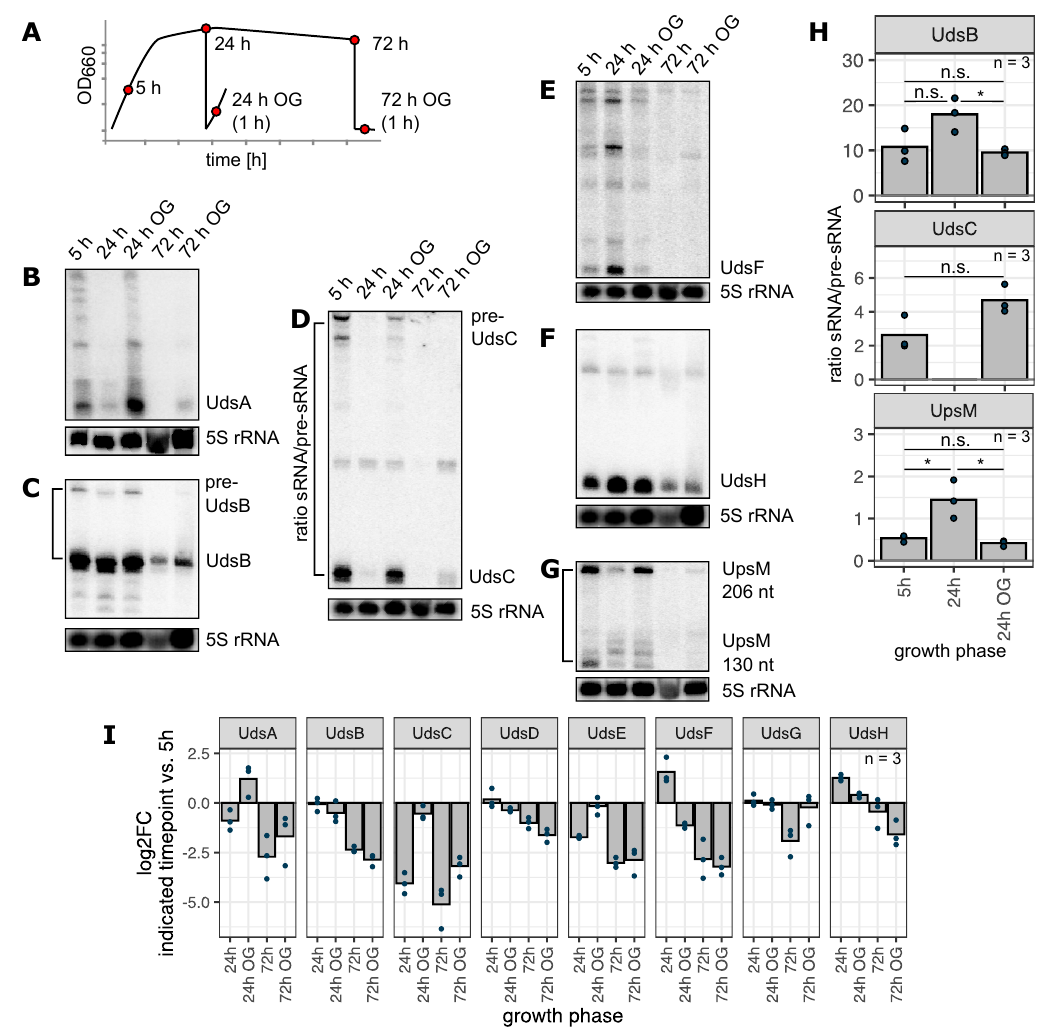
Figure 4. The UTR-derived sRNA levels strongly depend on the growth phase. ( A ) R. sphaeroides wild type cultures were incubated for 72h under microaerobic conditions. Cells were harvested at the depicted times (red dots). After 24 h and 72h, outgrowth cultures were inoculated. ( B – G ) Total RNA from the depicted samples was analyzed by northern blot using specific probes against UdsA to UdsH and UpsM. The sRNA levels vary throughout the different growth phases and can be increased or decreased when compared to the levels during the exponential phase. Loading control: 5S rRNA. Full blots with samples from biological triplicates are shown in Figure S5. Membranes were used with multiple probes: UdsA, UdsD and UdsE; UdsB, UdsG,UdsH and UpsM; UdsC and UdsF. ( H ) Signals of the sRNAs UdsB, UdsC and UpsM and their corresponding pre-sRNAs were quantified and the ratio was calculated (y-axis). Bars indicate the mean value, every dot represents one biological replicate, n = 3. Groups were compared with the two-sided Student’s t -test: * p -value < 0.05; n.s. not significant. ( I ) log 2 fold changes were computed comparing the sRNA abundances during the growth phases with the respective signal in the 5h sample. Quantification based on northern blot data, n =